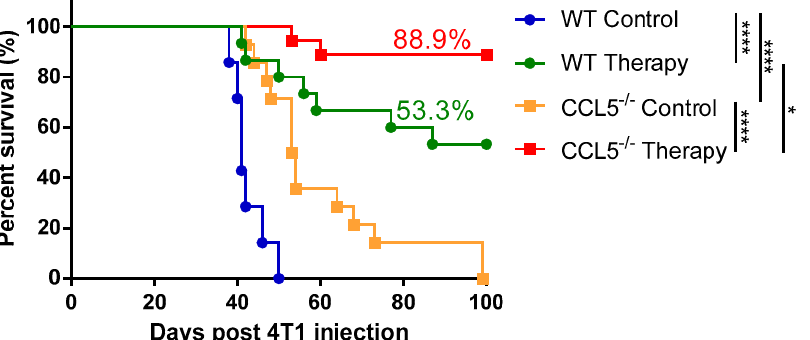
Figure 1. CCL5 deficiency prolonged the long-term survival of cryo–thermal therapy in the 4T1 model. Wild-type (WT) or CCL5 deficiency (CCL5 − / − ) mice were subcutaneously inoculated with 5 × 10 5 4T1 tumor cells and treated with cryo–thermal therapy on day 21 after inoculation. * p < 0.05; **** p < 0.0001. ( n = 7 in WT control; n = 15 in WT therapy; n = 14 in CCL5 − / − control; n = 18 in CCL5 − / − therapy).